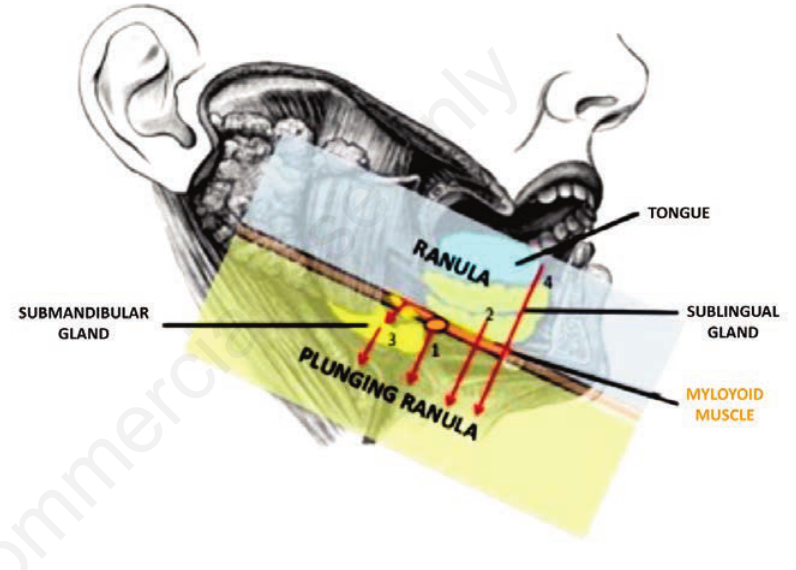
Figure 1. Pathogenetic mechanisms of plunging ranula development: 1) the sublingual gland may project through the mylohyoid to provide an origin; 2) the cyst may penetrate through the mylohyoid to join the sublingual gland in the mouth; 3) a duct from the sub- lingual gland may join the submaxillary duct and give rise to a ranula in continuity with the submandibular gland or its duct; 4) plunging ranulas may occur iatrogenically after surgery to remove oral ranulas. Table 1. Elements used to diagnose plunging ranula. Origin